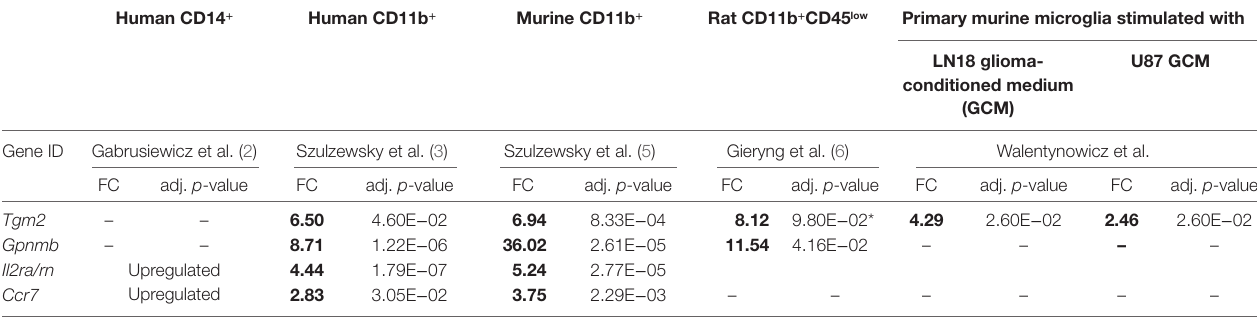
TaBle 1 | Top markers of glioma infiltrating